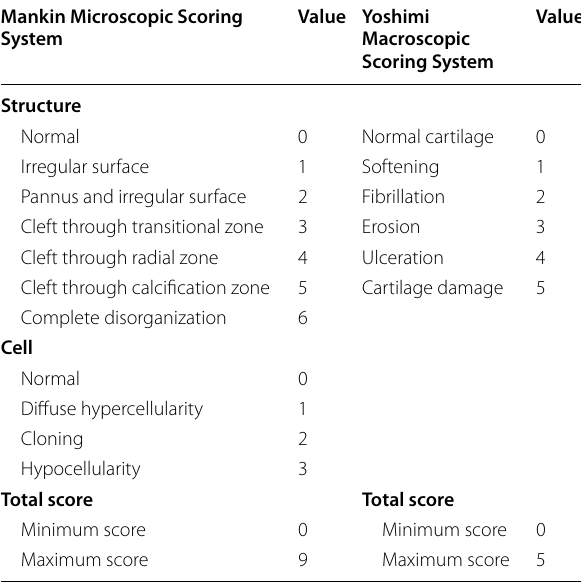
Table 1 Scoring systems for macroscopic and microscopic evaluation